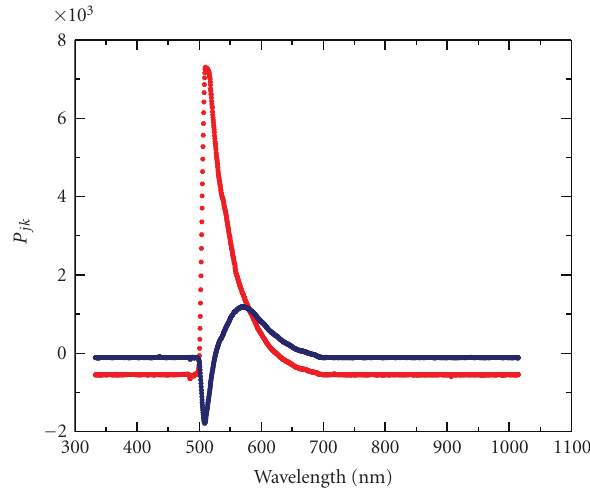
Figure 3: First two principal vectors of 52 fluorescence spectra. The elements of the first two principal vectors, P 1 k and P 2 k , respectively, are plotted against the 2048 wavelengths where each of the 52 fluorescence spectra was measured. Each measured spectrum can be approximated by the linear combination of these two curves (see (4)). The first and second principal vectors are marked by red and blue dots, respectively.